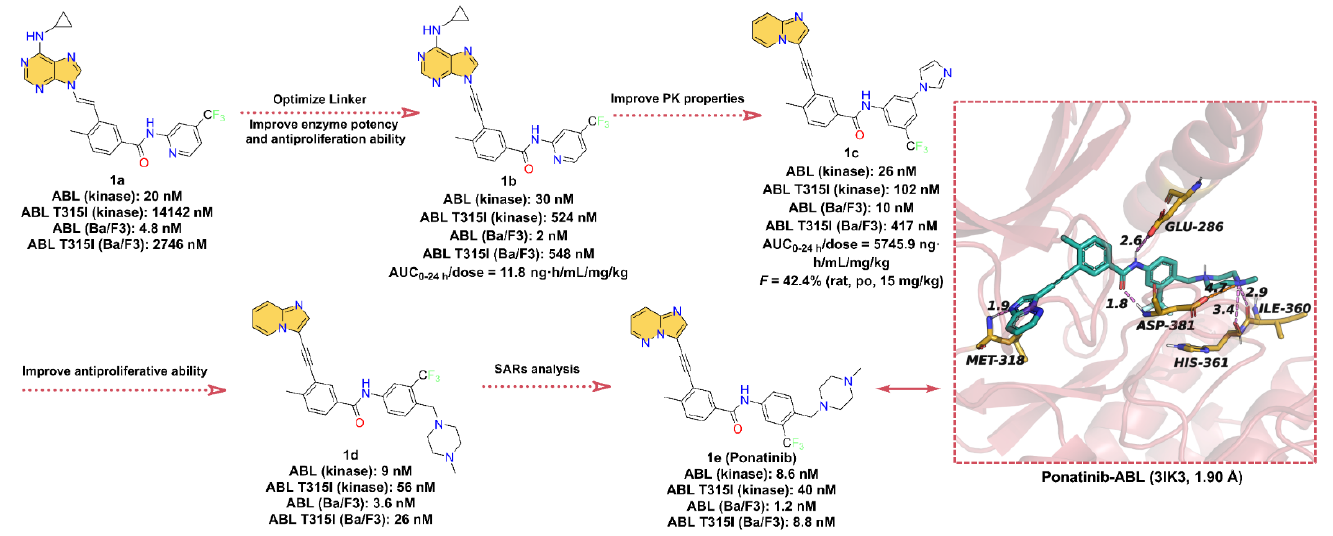
Figure 1. Key medicinal chemistry optimization leading to Ponatinib and its binding model with Bcr-Abl.